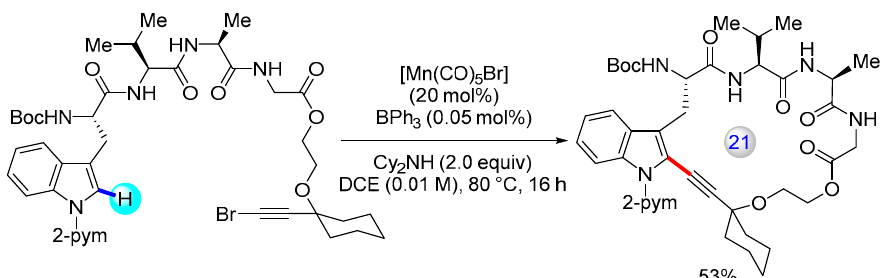
Figure 11. Peptide macrocyclization via manganese-catalyzed intramolecular C(sp 2 )–H alkynylation [70].